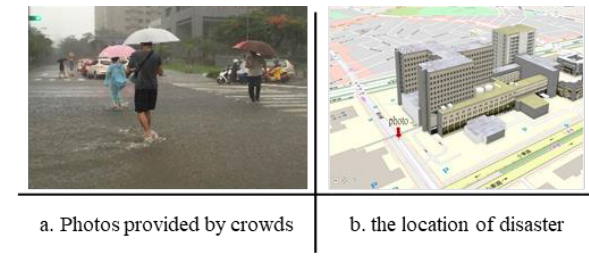
Figure 15 The reported disaster situation.